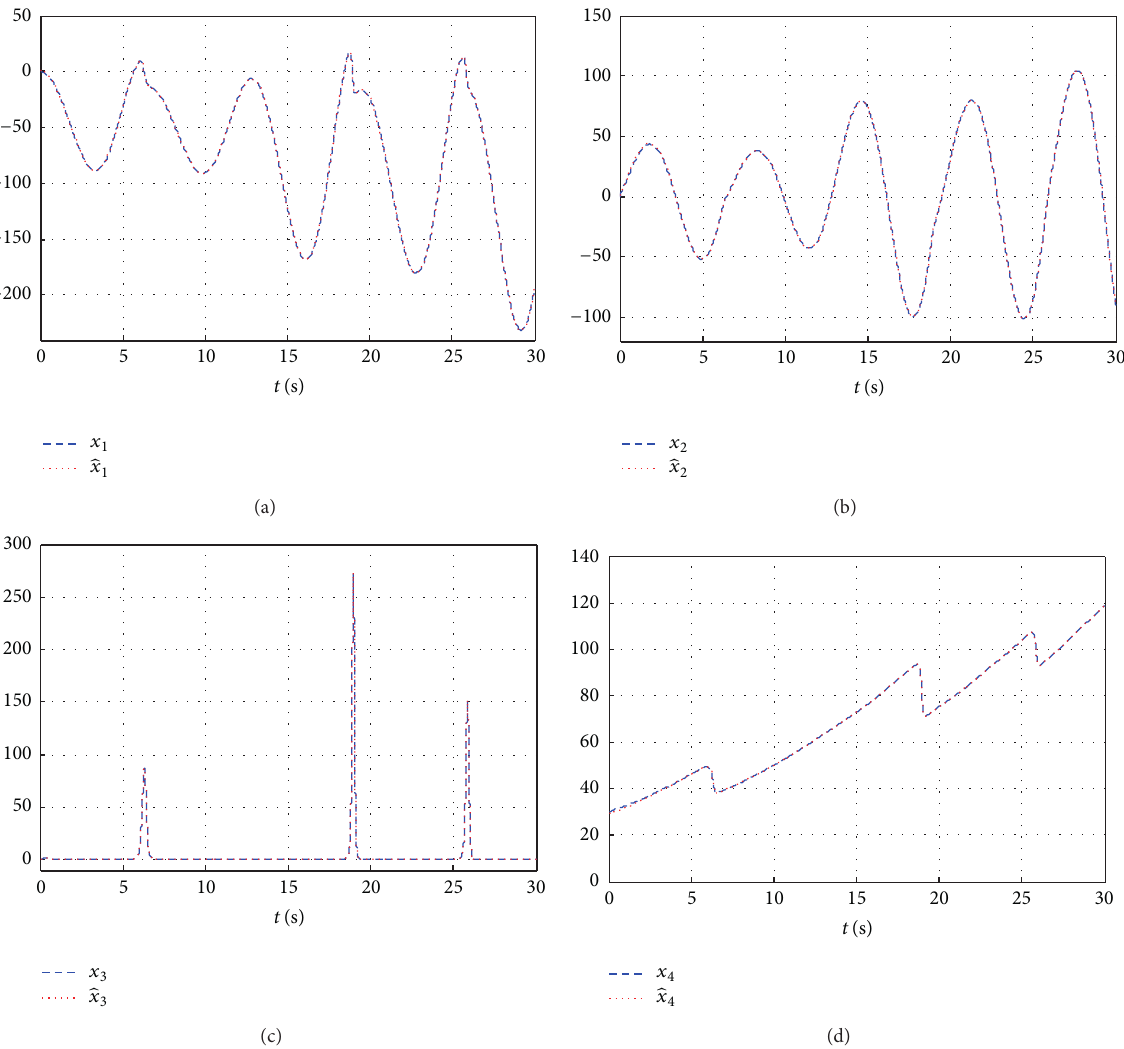
Figure 9: (a) The state 𝑥 1 (𝑡) and its estimated ̂𝑥 1 (𝑡) . (b) The state 𝑥 2 (𝑡) and its estimated ̂𝑥 2 (𝑡) . (c) The state 𝑥 3 (𝑡) and its estimated ̂𝑥 3 (𝑡) . (d) The state 𝑥 4 (𝑡) and its estimated ̂𝑥 4 (𝑡) .